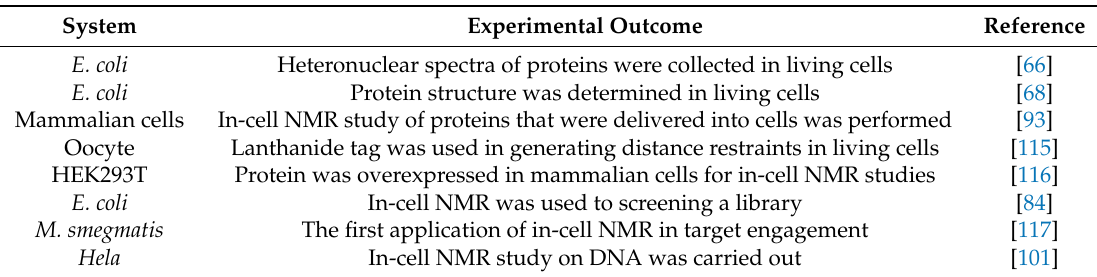
Table 3. Some representative in-cell NMR